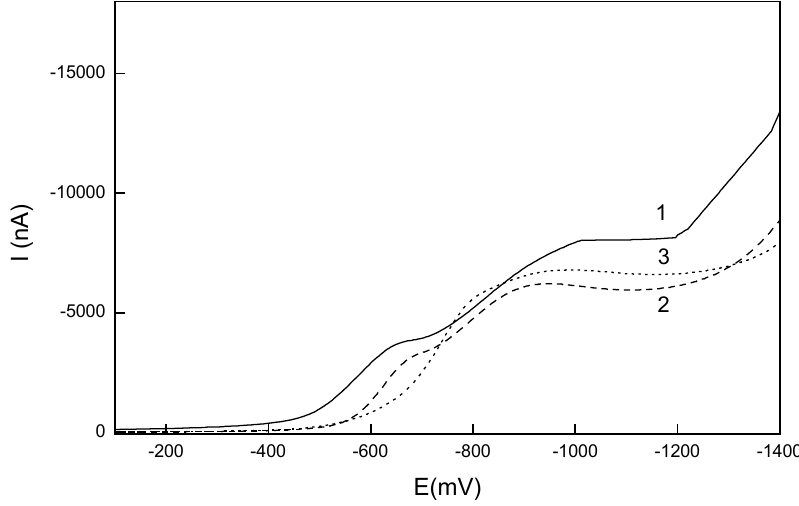
Figure 5. Selected LS voltammograms of 1-NP (c=1.10 -4 mol.L -1 ) at GCPE in mixture of a BR buffer : MeOH (1:9 v/v) with buffer pH 3 (1), 5 (2) and 8